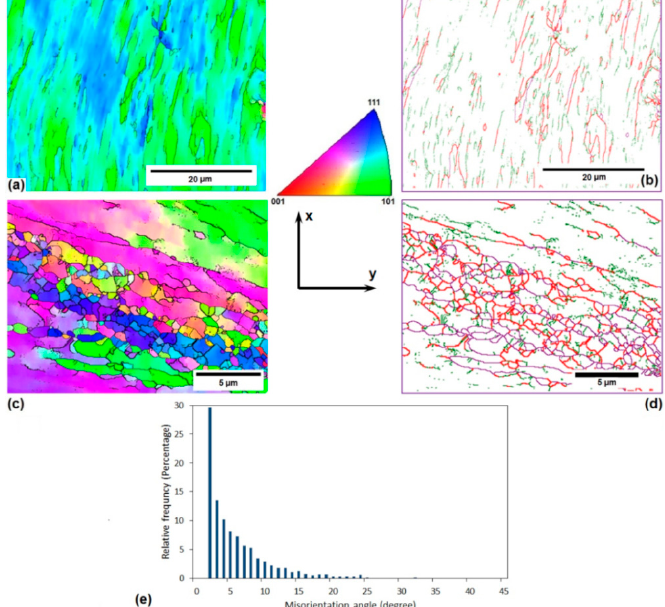
Figure 6. Microstructure features of solution ‐ treated AA ‐ 6063 alloy after three passes of MFD process at 177 °C: ( a , c ) the EBSD grain orientation map, ( b , d ) the EBSD grain boundary map, and ( e ) the misorientation angle distribution diagram.